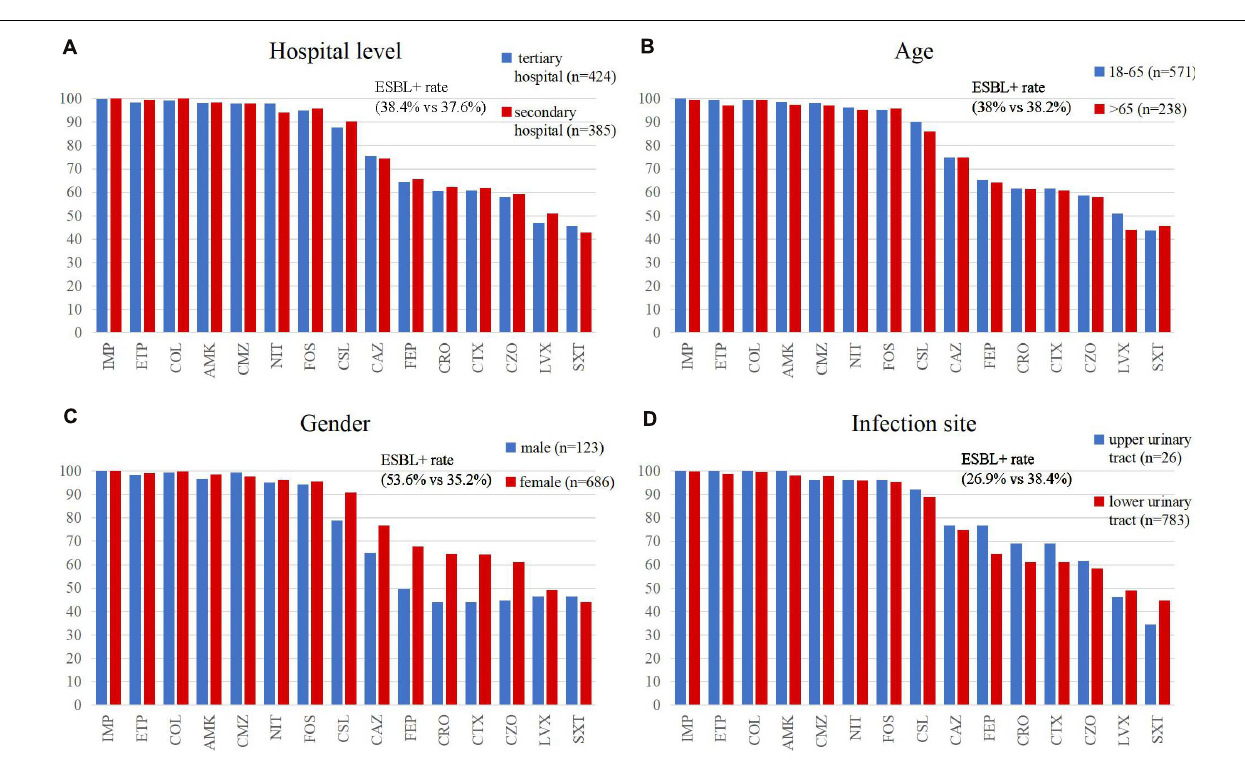
FIGURE 5 | Comparison of the antimicrobial susceptibility rates of E. coli isolates by (A) hospital category, (B,C) demographic characteristics, and (D) clinical features. IMP, imipenem; ETP, ertapenem; COL, colistin; AMK, amikacin; CMZ, cefmetazole; NIT, nitrofurantoin; FOS, fosfomycin; CSL, cefoperazone/sulbactam; CAZ, ceftazidime; FEP, cefepime; CRO, ceftriaxone; CTX, cefotaxime; CZO, cefazolin; LVX, levofloxacin; and SXT,